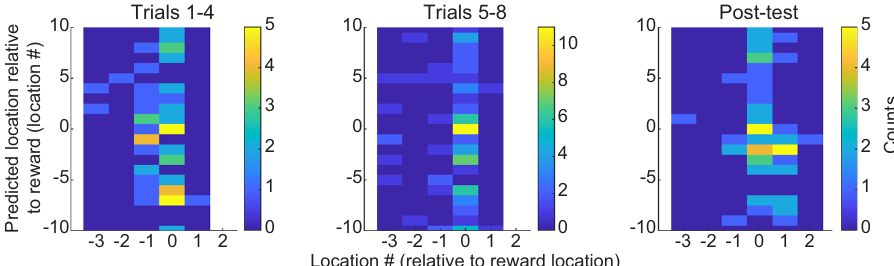
Fig. 8 Locations represented at the end of replay sequences plotted against animals ’ actual stop locations. The y -axis shows the location represented at the end of each replay sequence detected during rest periods of all trials (correct trials correspond to stop location 0 and error trials correspond to other stop locations). The x -axis shows rats ’ actual stop locations for all trials. Actual stop locations ranging from − 3 to − 1 indicate that rats stopped at incorrect locations that were 3 to 1 locations before the correct location (i.e., undershoot error trials). Actual locations ranging from 1 to 3 indicate stop locations that were 1 to 3 locations after the correct reward location (i.e., overshoot error trials). Actual locations equal to 0 indicate that rats stopped at the correct reward locations (i.e., correct trials). The colorscale shows the trial counts for each x – y pairing. Results from errors in trials 1 – 4, trials 5 – 8, and post-test trials are shown in left, middle, and right panels, respectively. Matthews correlation coef fi cients were close to zero (equal to 0.0715, 0.0390, 0.0160, respectively, for left, middle, and right panels, with corresponding bootstrap estimates of 0.0713± 0.0380, 0.0431 ± 0.0271, 0.0197